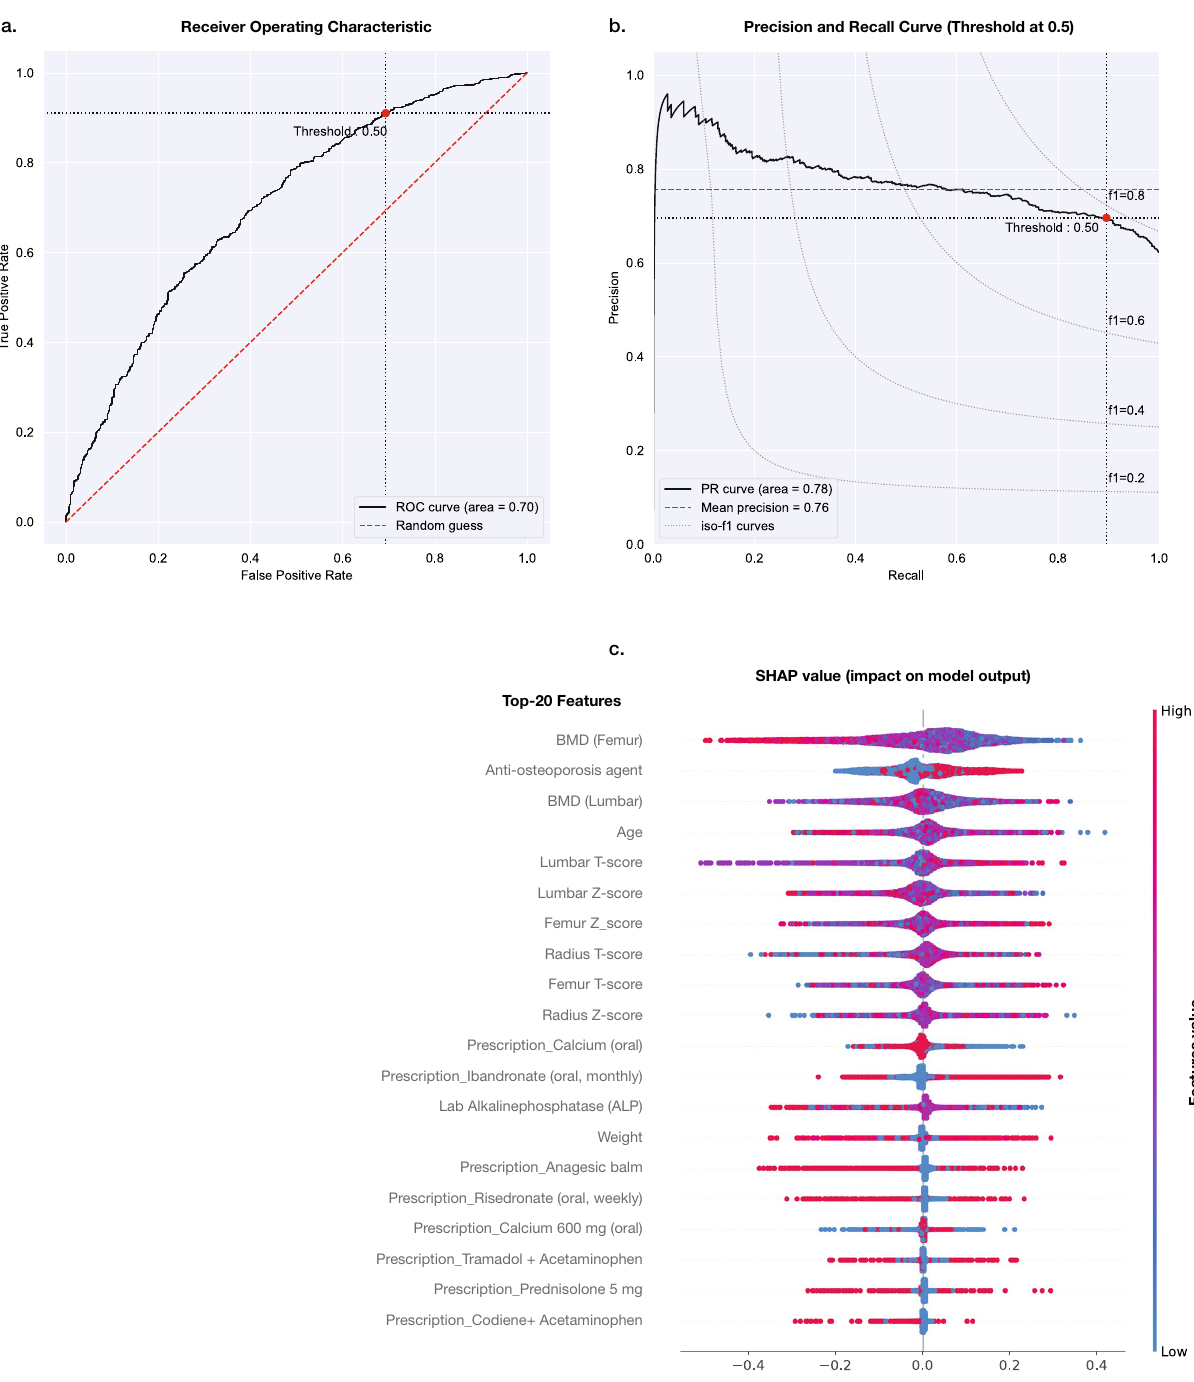
Figure 6. Random Forests classifier model characteristics. ( a ) Reciever-operting characteristic curve (ROC) of the model with AUC of 0.70. ( b ) Precision and Recall (PR) curve for the model achieved AUC of 0.78. ( c ) Variable contribution of the model by SHAP Value. The importance of variables were ranked in descending order. The blue and red color represent low and high value of the variables,